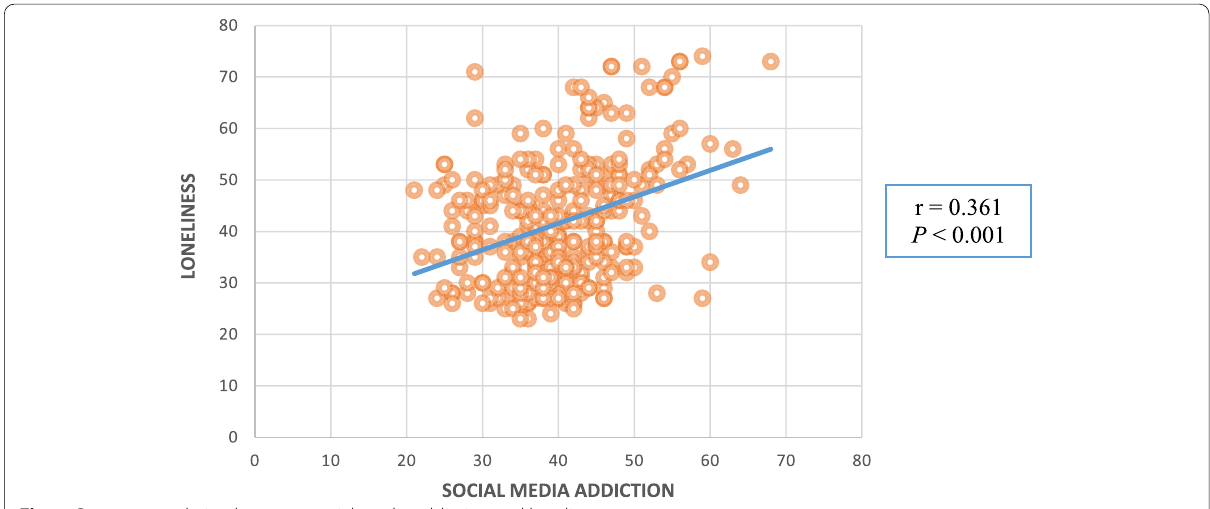
Fig. 1 Pearson correlation between social media addiction and